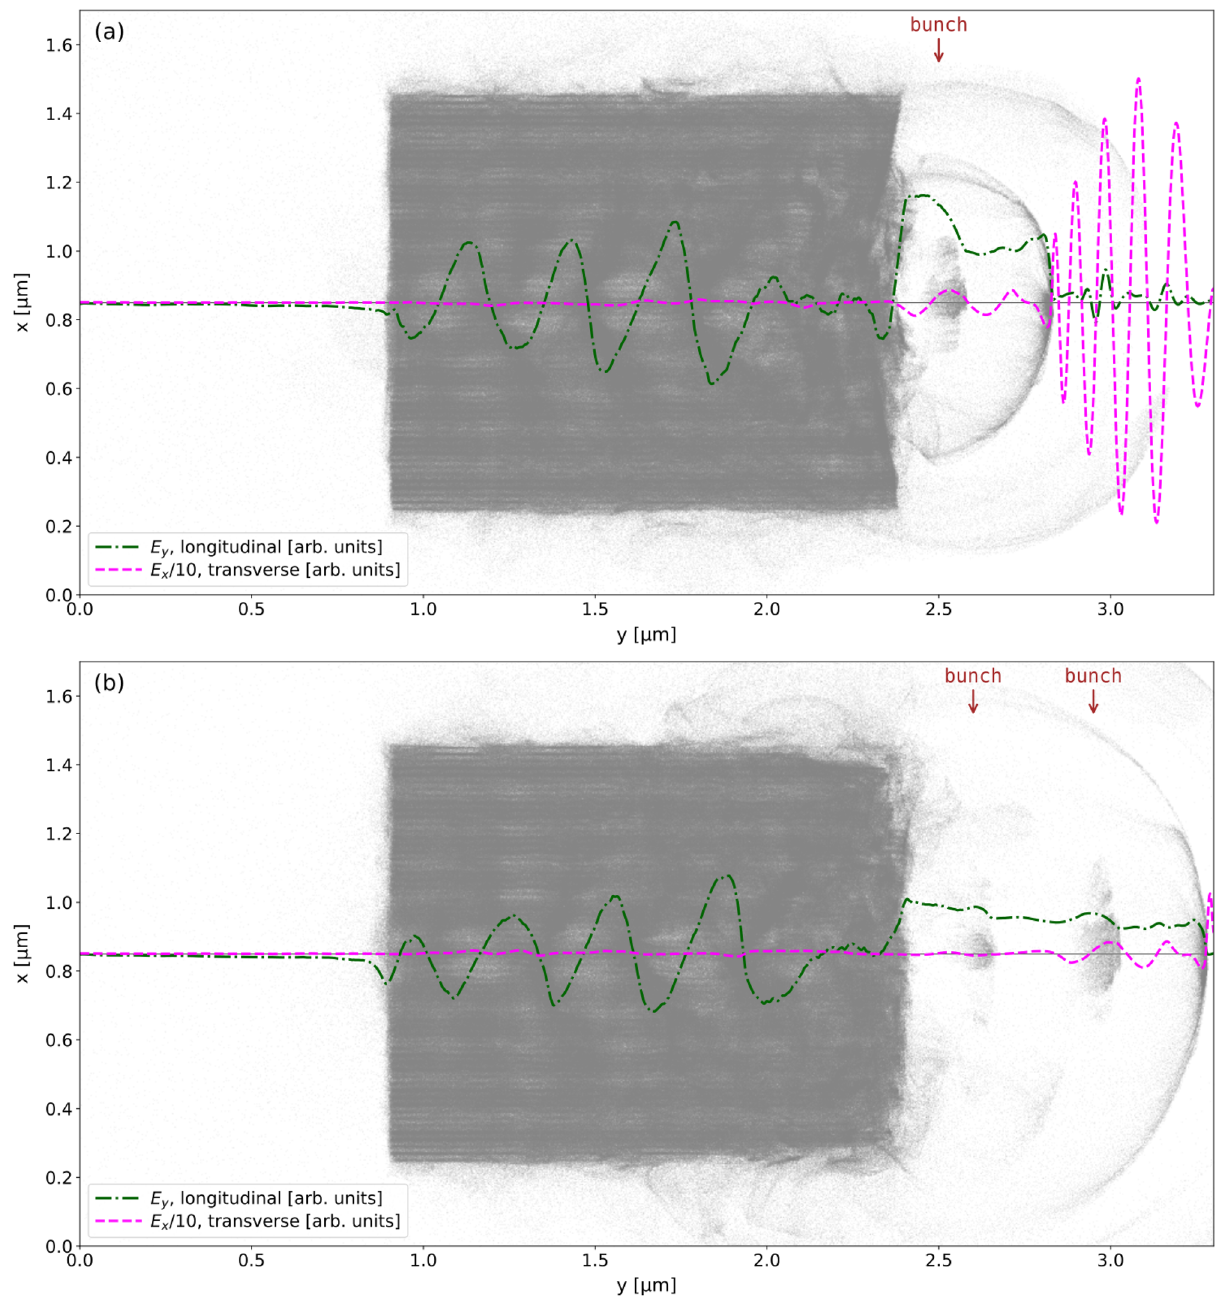
Figure 10. Extraction of the electron bunches in the wake of the laser pulse, shown by the dashed magenta line, using unionized Carbon atoms: ( a ) two halos are formed as the laser pulse leaves the target, with the first electron bunch extracted and ( b ) 4.5 laser cycles later, a second electron bunch of lower charge is extracted with a separation of 1.2 fs from the first